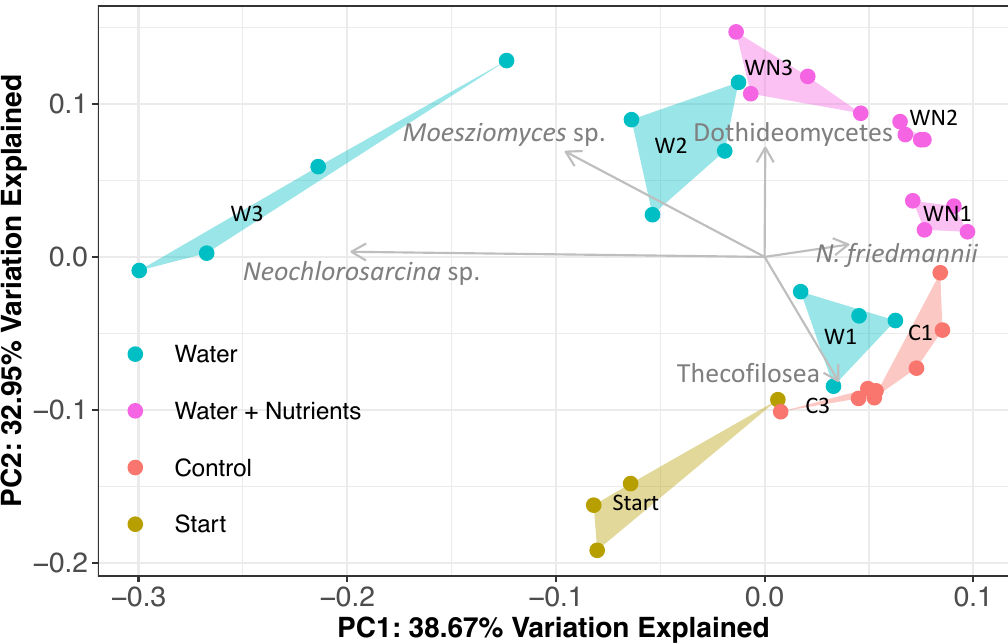
Figure 6. Principal coordinate analysis (PCoA) ordination plot of eukaryotic communities in soil microcosms. Repeated water additions to water- and nutrient-amended microcosms exposed to freeze–thaw cycles significantly changed the eukaryotic community (PERMANOVA p < 0.001, R 2 = 0.75). ThevectorlengthisproportionaltothecorrelationbetweenthePCoAaxesandtheOTUsthatcontributed most to the observed dissimilarity among treatments (SIMPER). Communities became increasingly di ff erent from controls following multiple